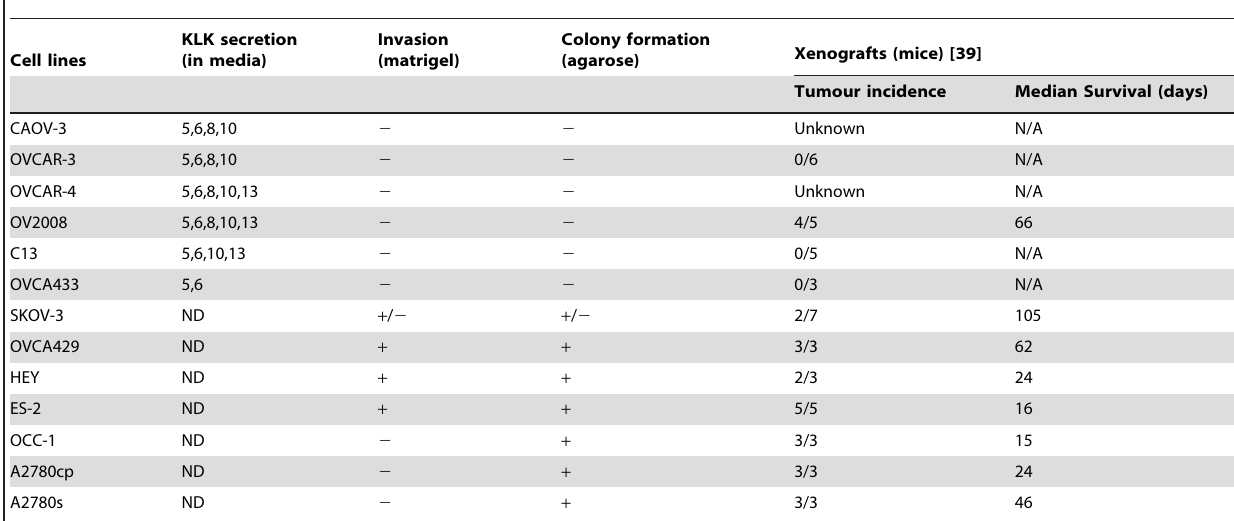
Table 1. Kallikrein expression profile and tumorigenicity in a panel of 13 ovarian cancer cell lines.